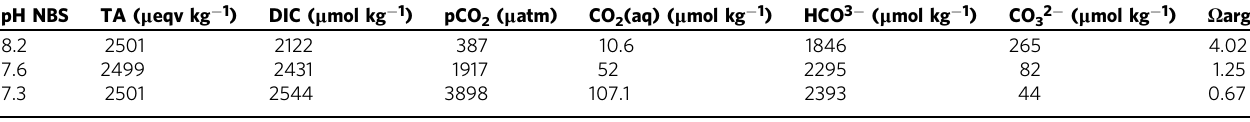
Table 1 Carbonate chemistry parameters of treatments and control pH